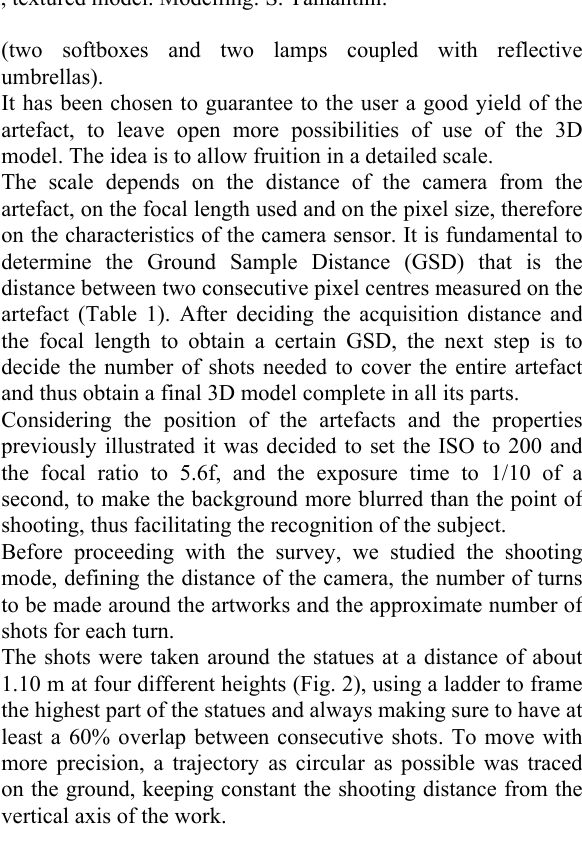
Figure 3 . Creation of dense cloud, mesh model, textured model. Modelling: S. Tamantini.